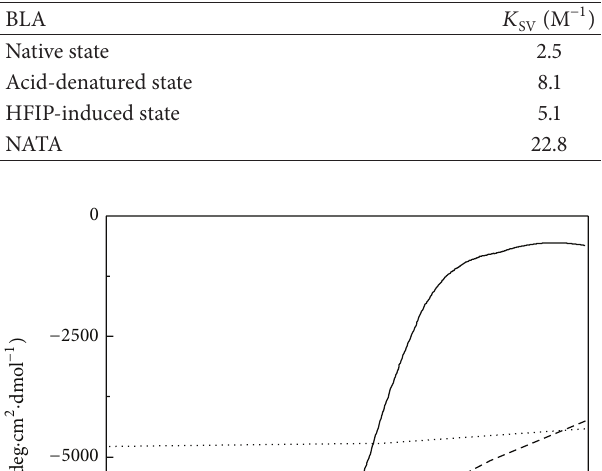
) of different con- SV